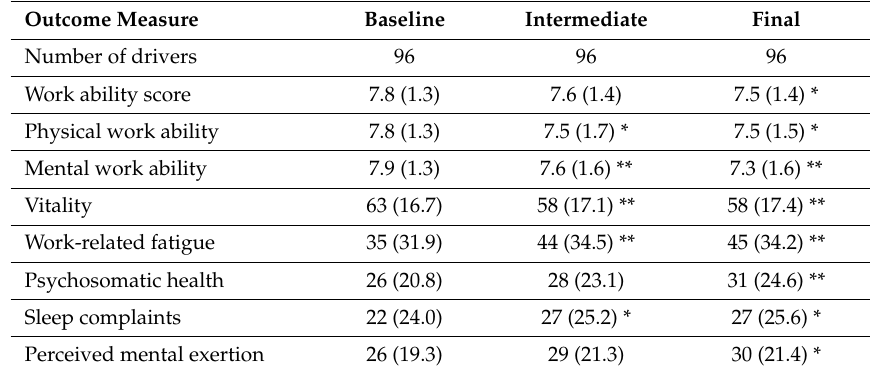
Table A1. Values (mean ± SD) for the outcome variables for the entire group of drivers at the baseline, intermediate, and final measurements, with the last observation carried forward and-intention to-treat